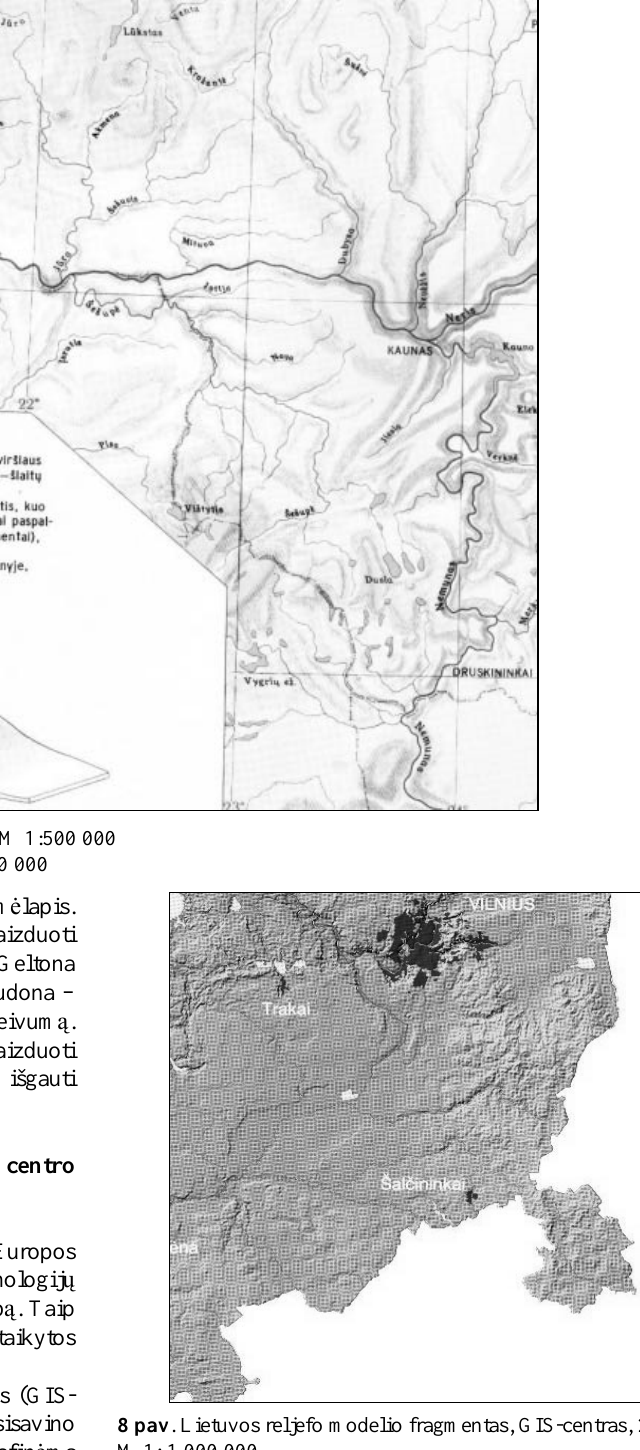
Fig 8. Fragment of relief model of Lithuania,